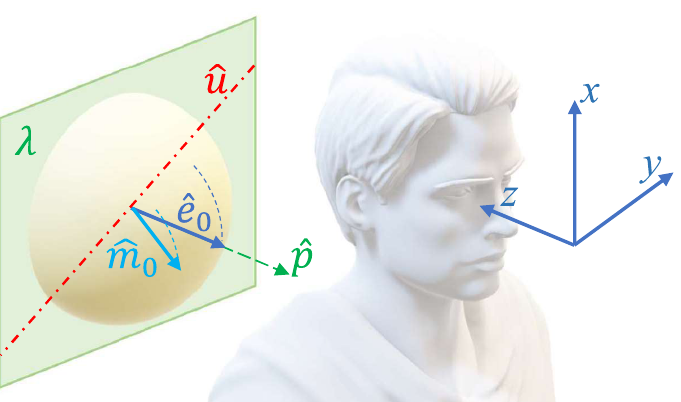
Figure 3. Definition of the axes and geometry of the Listing’s model. The primary orientation ˆ e 0 (along the normal ˆ p to the Listing’s plane λ ) is nearly parallel to ˆ z . In our setup, when the eye is in its primary orientation the magnetic dipole is generically oriented ( ˆ m 0 ). When the gaze varies, both vectors (cid:126) m and ˆ e undergo rotations (dashed arcs) obeying the Listing’s law: each accessible configuration is such that it could be reached from the primary orientation with one rotation around an axis laying on λ . In this figure, the direction ˆ u embodies one of those